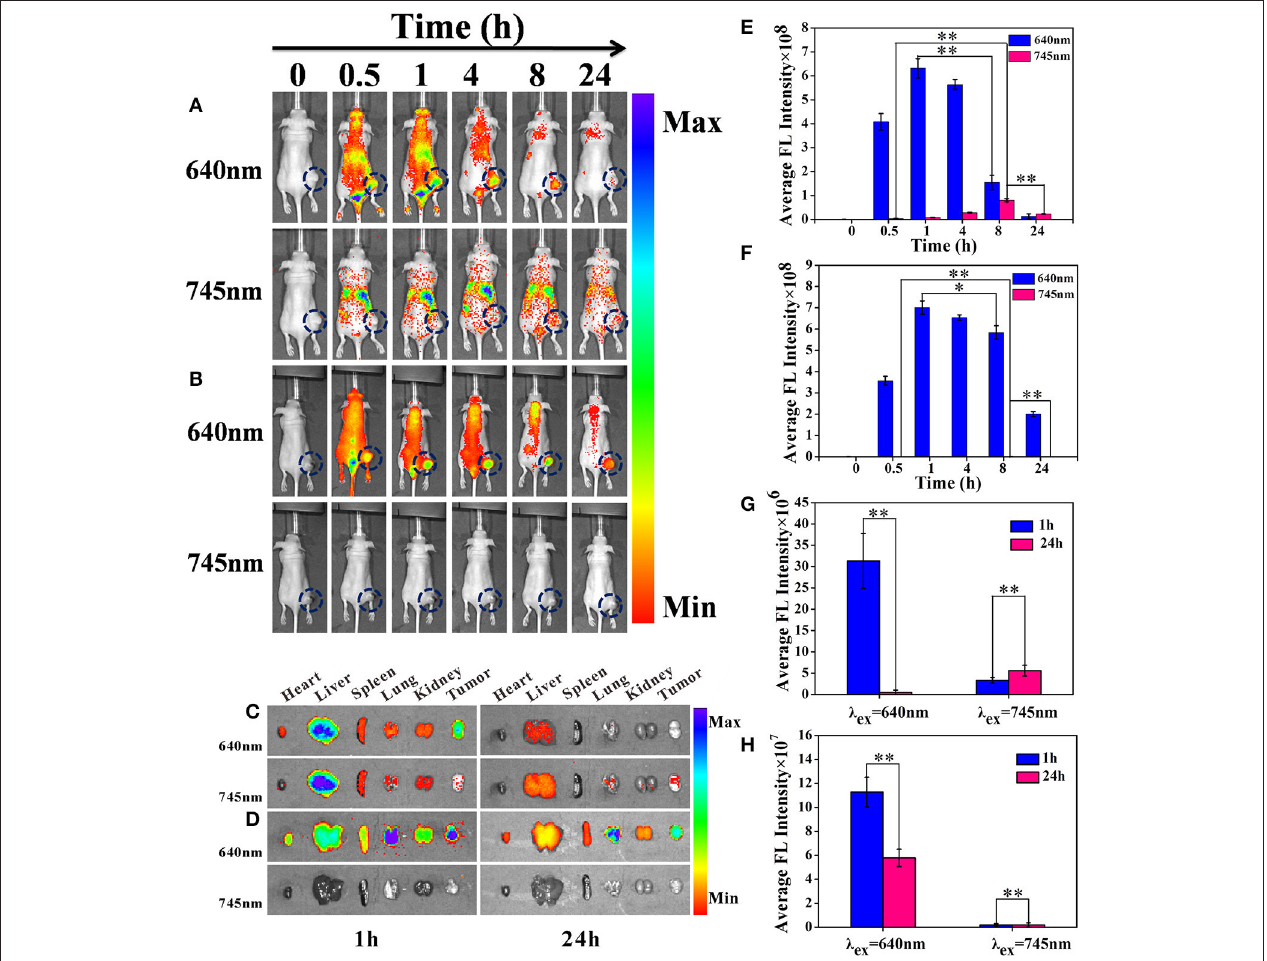
FIGURE 7 | In vivo biodistribution and NIRF imaging of Cy-SS-MTX in tumor-bearing mice at 0/0.5/1/4/8/24h after intravenous injection. (A) The groups injected by Cy-SS-MTX excited by 640nm and 745nm respectively. (B) The groups injected by Cy-CC-MTX excited by 640 and 745nm respectively. Ex vivo NIRF image of normal organs and tumors for the mice injected with Cy-SS-MTX (C) Cy-CC-MTX (D) at 1 or 24h post-injection. (E,F) Semiquantitative average FL signals in the tumor sites of (A,B) respectively. Ex vivo fluorescent images of normal organs and tumors excised at 1 and 24h post-injection with Cy-SS-MTX (E) and Cy-CC-MTX (F) . (G,H) Semiquantitative average FL signals in the tumors sites of (C,D) respectively. Note that the samples were all excited by 640 and 745nm respectively. Red fluorescence excited by 745nm represents the drug release. (*denotes P < 0.05, **denotes P < 0.01 significant